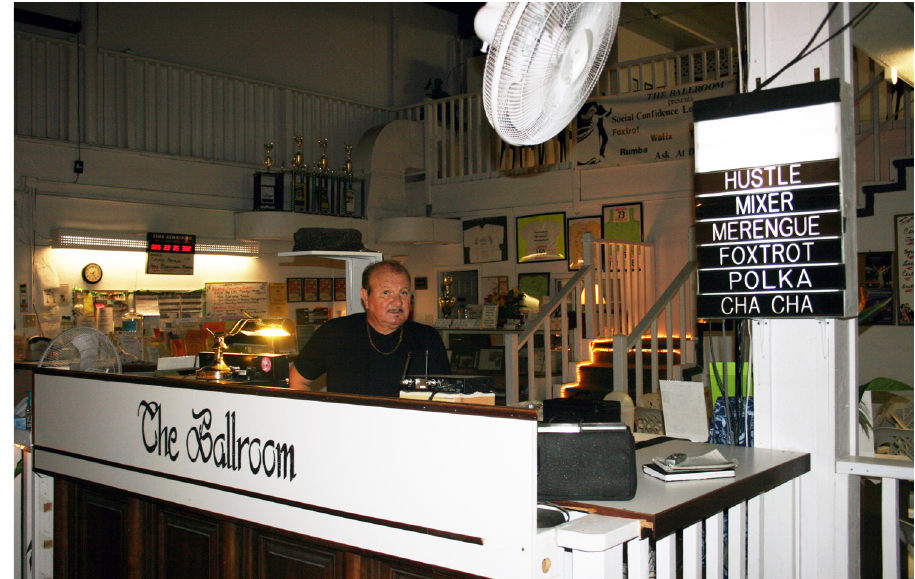
Figure 2 ‘Dance4Life’ programme at The